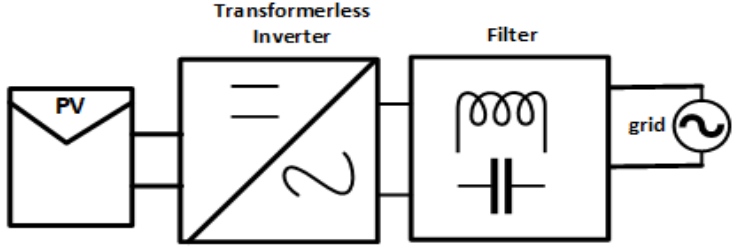
Figure 2. Single-phase grid-connected PV systems with transformerless inverter.